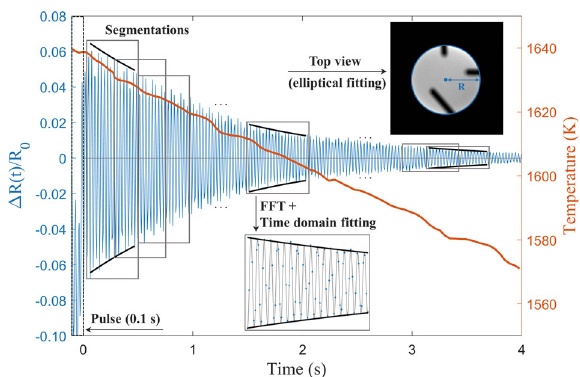
Fig. 9 Typical damping curve of an oscillating droplet. The viscosities were measured at different time segments representing a temperature range between 5 and 10